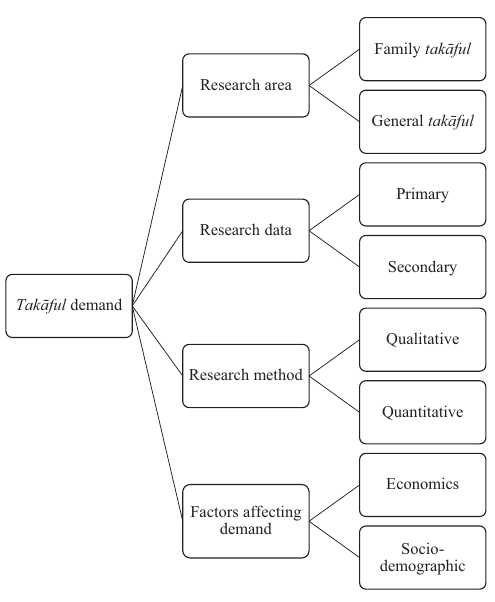
Figure 2. Content